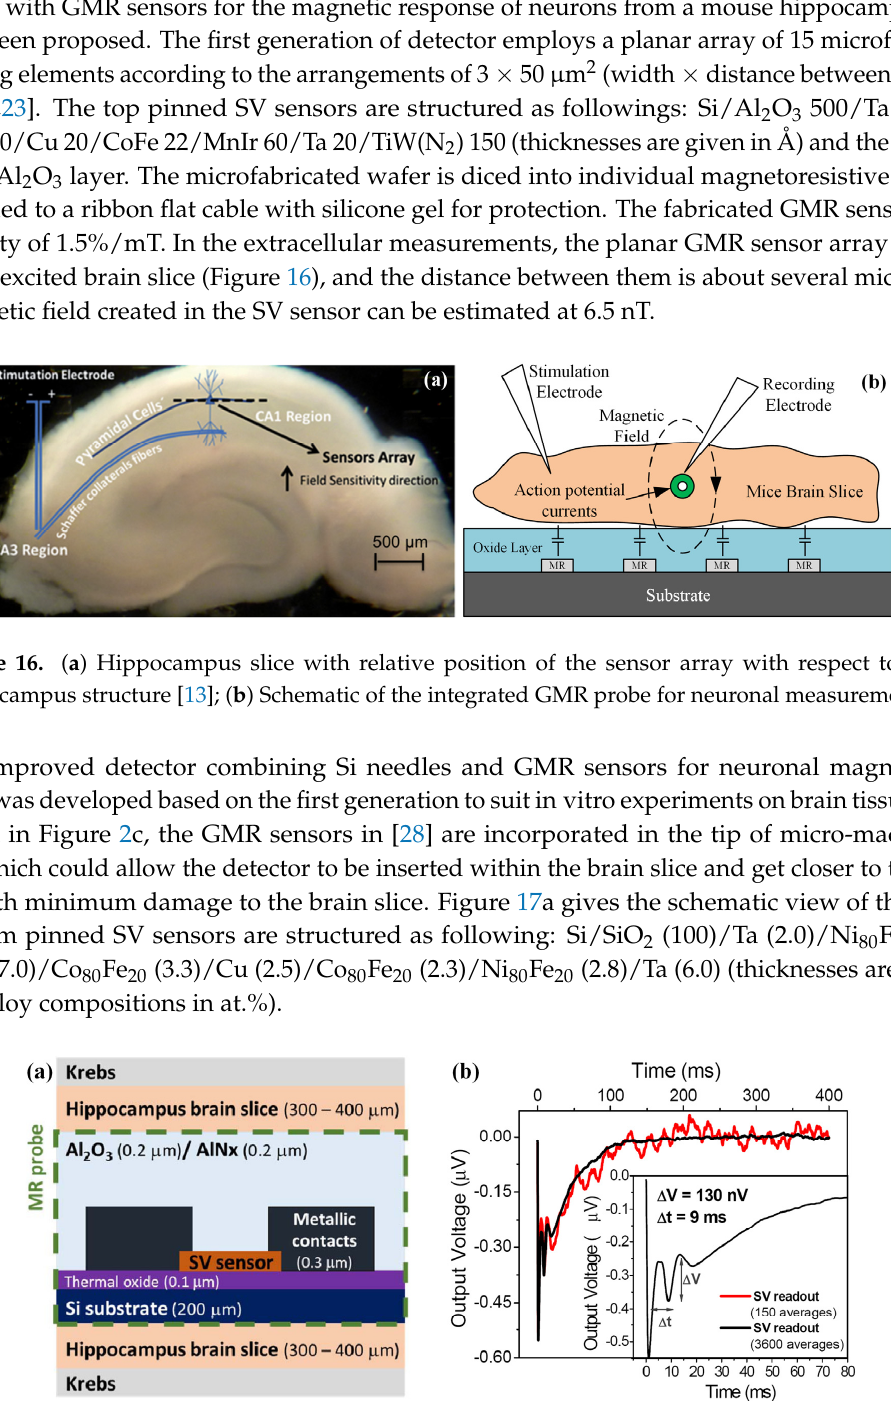
Figure 17. ( a ) Schematic view of the integrated GMR ‐ based Si needle cross section; ( b ) Recording of SV sensor generated by the action potential currents resulting from the activation of multiple neurons